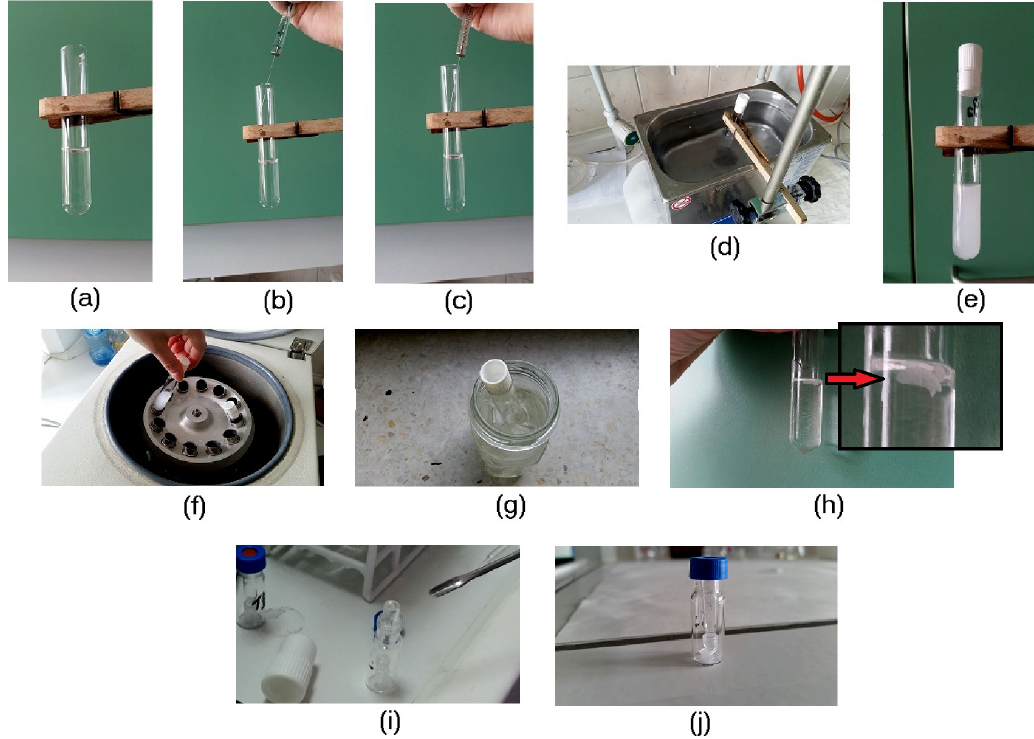
Figure 1. Stages of ultrasound-assisted emulsification-microextraction with solidification of the floating organic drop (USAEME-SFOD): ( a ) Placing test solution in a test tube; ( b ) adding acetic anhydride; ( c ) adding 1-undecanol; ( d ) subjecting the sample to sonication; ( e ) sample after sonication; ( f ) placing the tube in a centrifuge; ( g ) cooling in an ice bath; ( h ) a solid drop of solvent; ( i ) transferring the drop into a chromatography vial; ( j ) sample ready for GC-MS analysis.